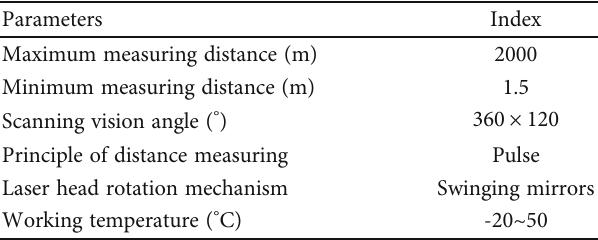
Figure 2: Placement of 3D laser scanner. Table 1: Parameters of 3D laser